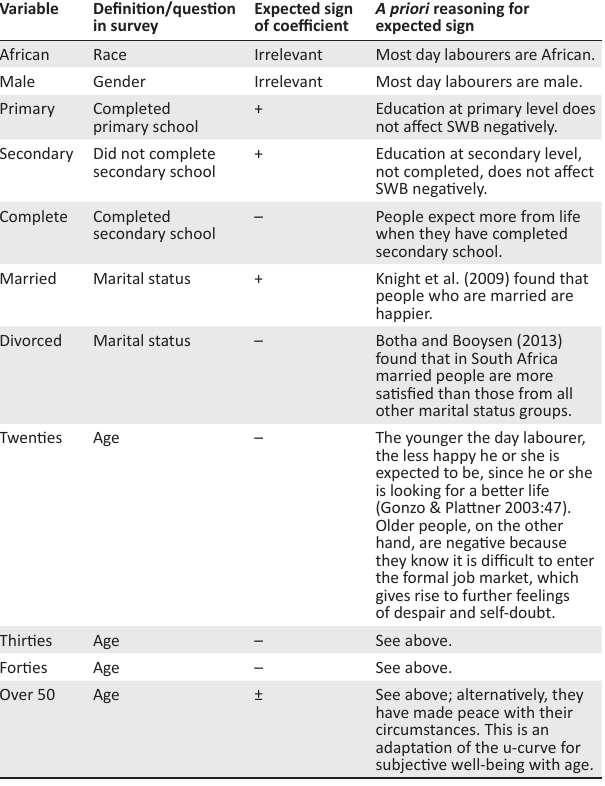
TABLE 8: Basic demographic